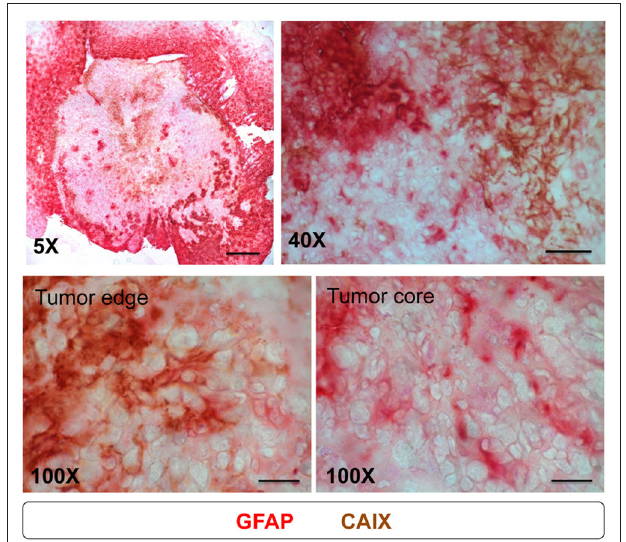
FIGURE 7 | Astrocytes expressed CAIX at tumor edge, but not at tumor core. Mice were sacrificed on day 21 after I.C. inoculation of ALTS1C1 tumor. For examining the correlation of astrocyte and CAIX expression in tumors, sections were double staining by astrocyte marker GFAP (red) and hypoxia-associated marker CAIX (brown). Scale bar = 500 µ m for 5X magnification, 50 µ m for 40X magnification, and 20 µ m for 100X